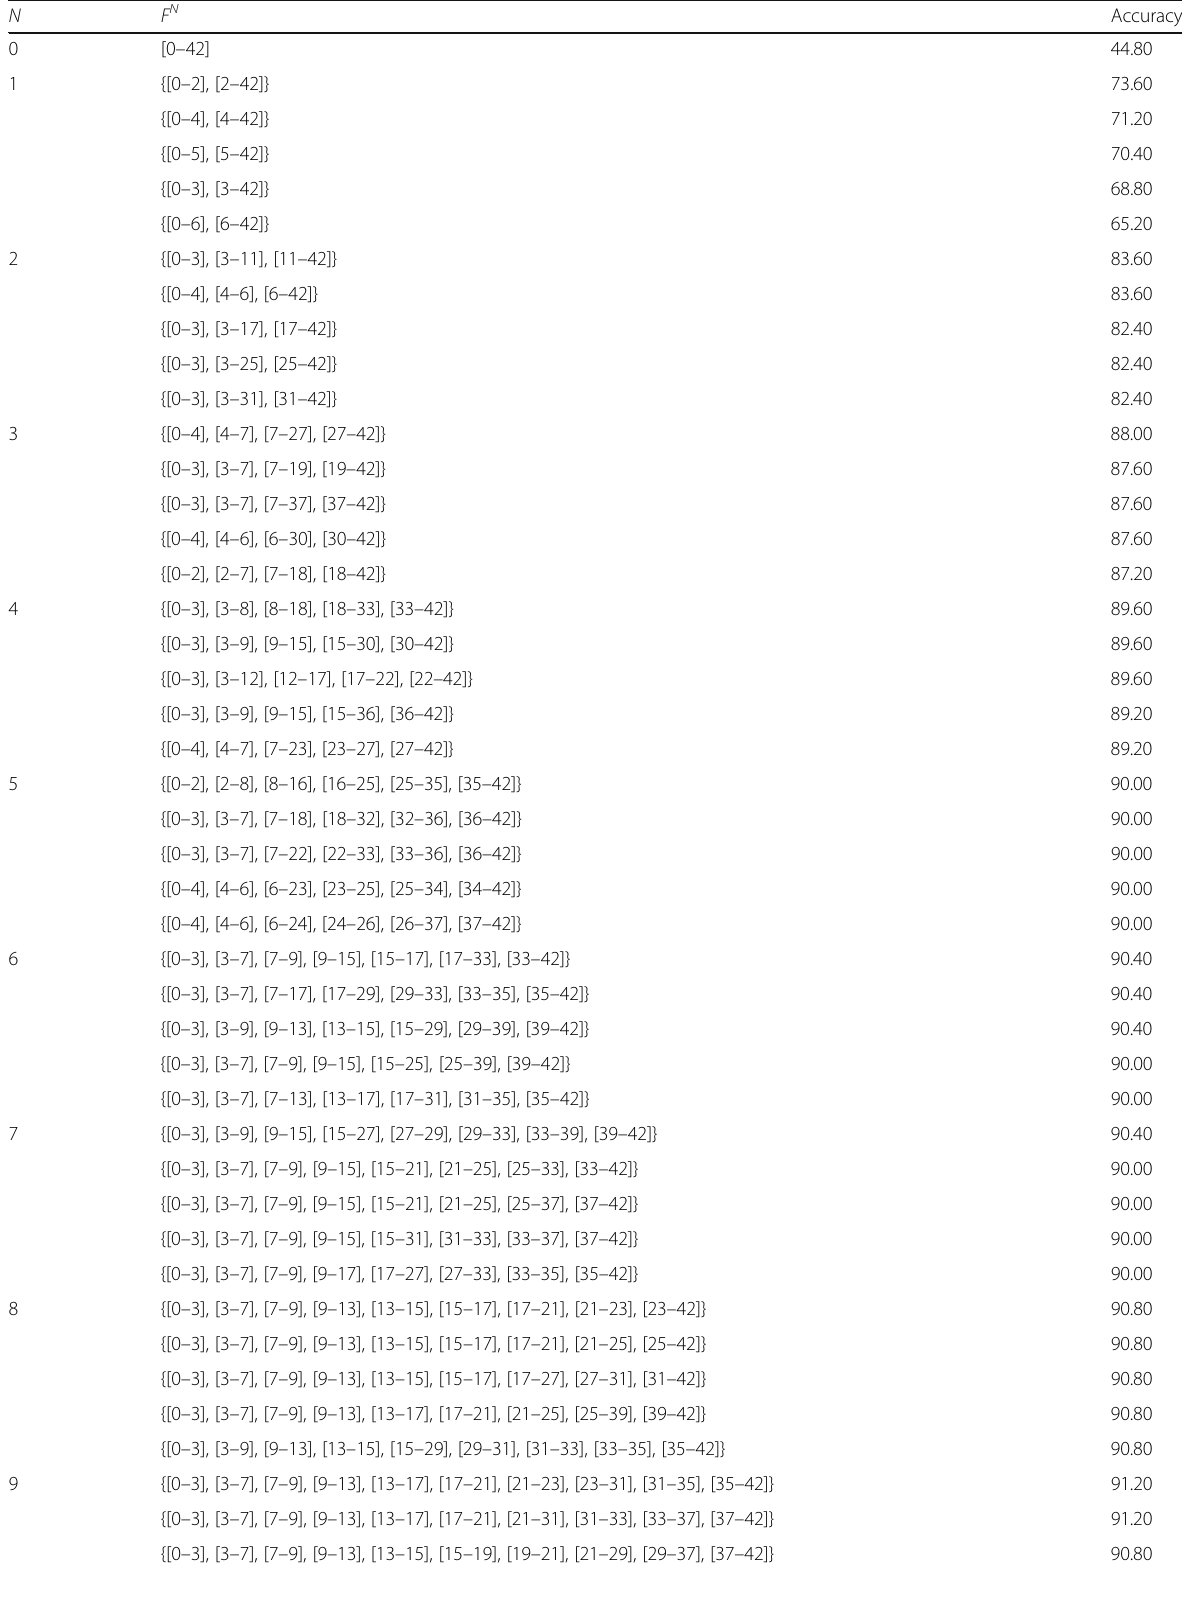
Table 5 Top 5 accuracy results for the five-class problem and the respective frequency sub-bands ( F N ) N F